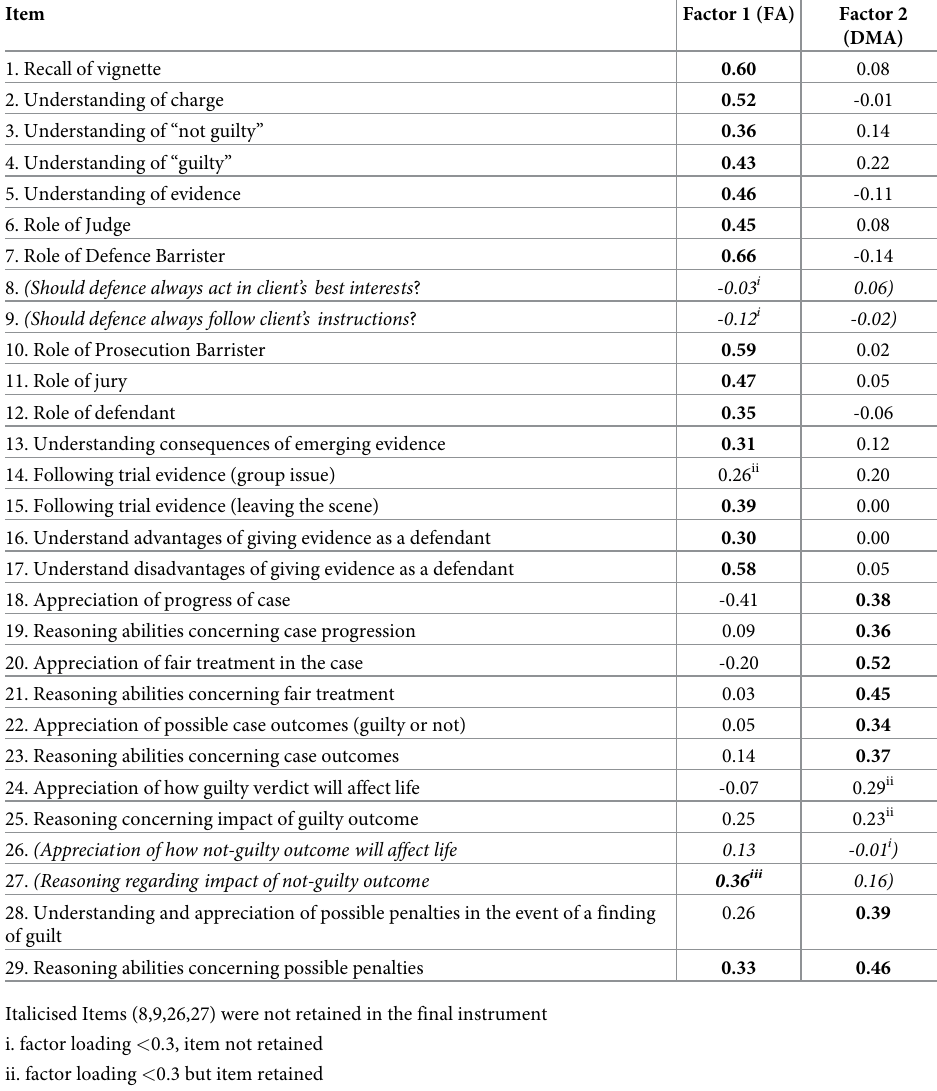
Table 2. Rotated factor matrix of the 29 item FTPA-instrument.